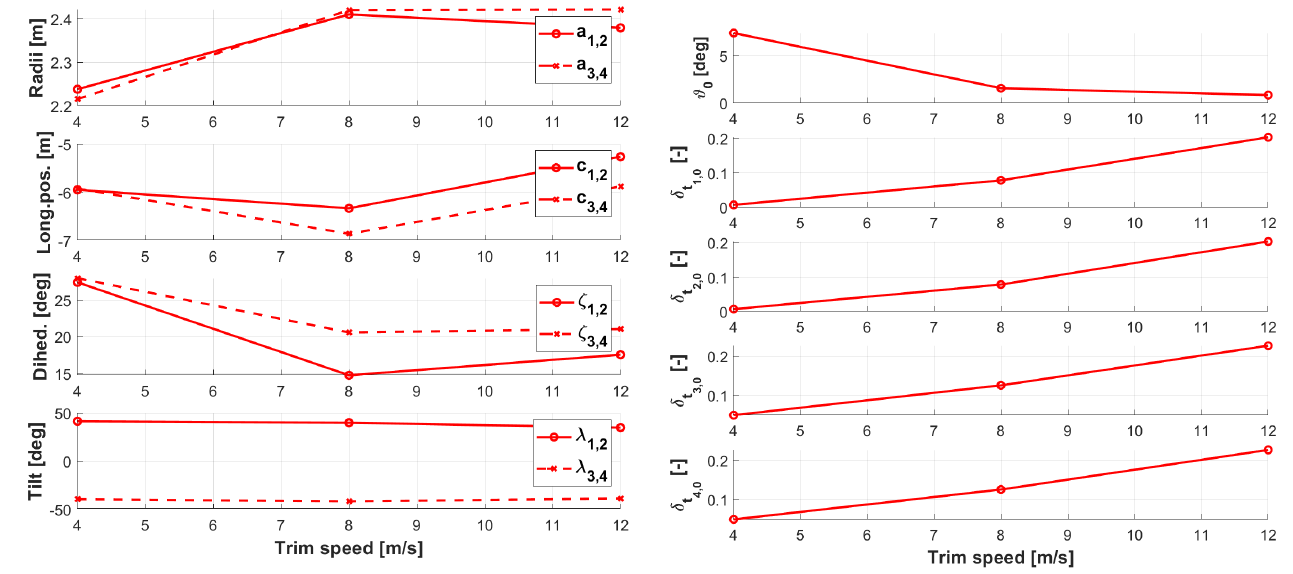
Figure 12. Optimal solutions ( left ) and trim results for optimizations at different airspeeds on layout